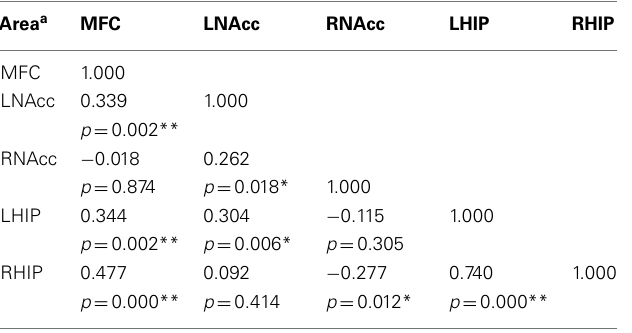
Table 4 | Functional connectivity between regions of interest during all three task conditions at baseline.